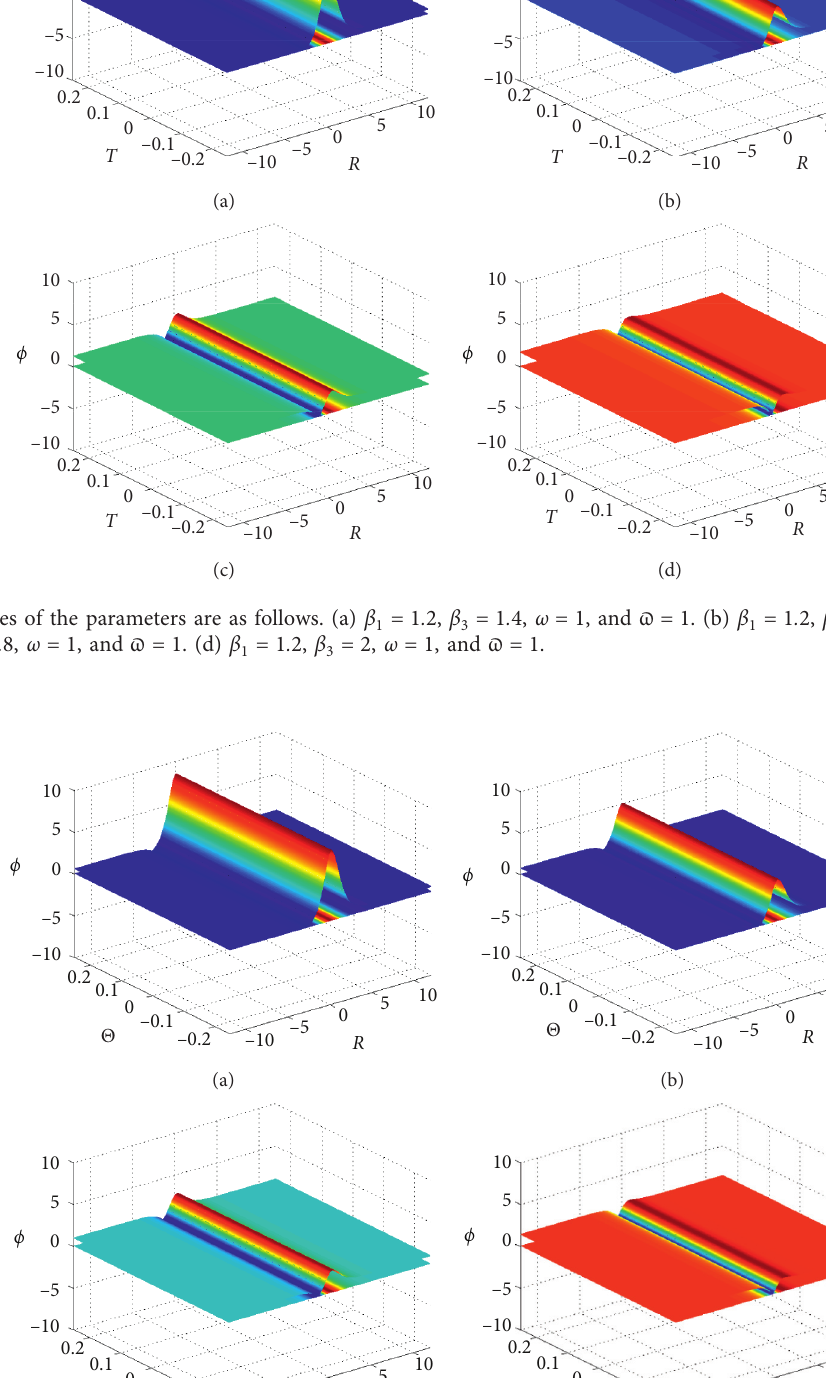
� 1 . 2, λ � 1 . 3, ω � 1, and ϖ � 1. (b) β 1 � 1 . 2, λ � 1, ω � 1, and ϖ � 1. 1